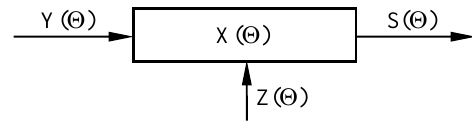
Fig. 1. Diagram of the object general